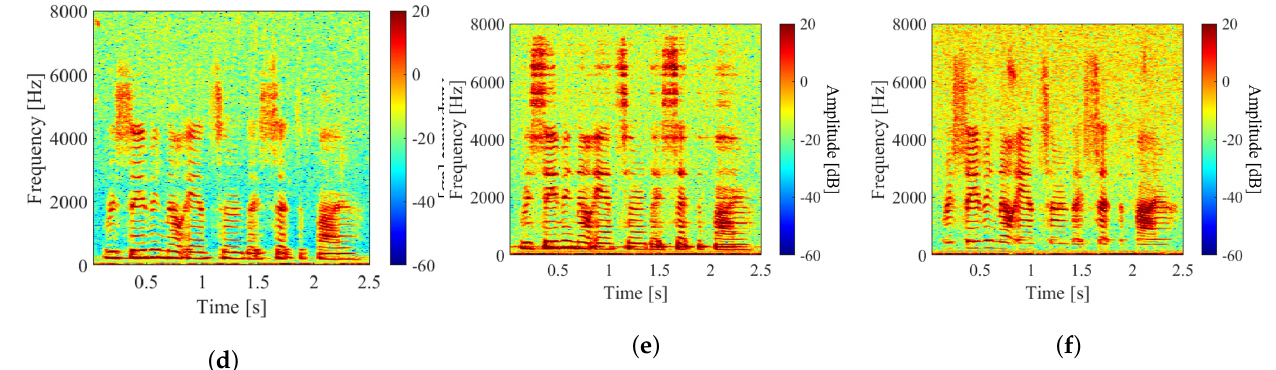
Figure 1. Power spectrum of observed speech acquired from different irradiated objects, i.e., ( a ) clean speech, ( b ) PET bottle, ( c ) cardboard box, ( d ) printing paper, ( e ) aluminum sheet, and ( f ) plastic plate. All objects were placed about 0.1 m from the sound source, and the output sound pressure was 85